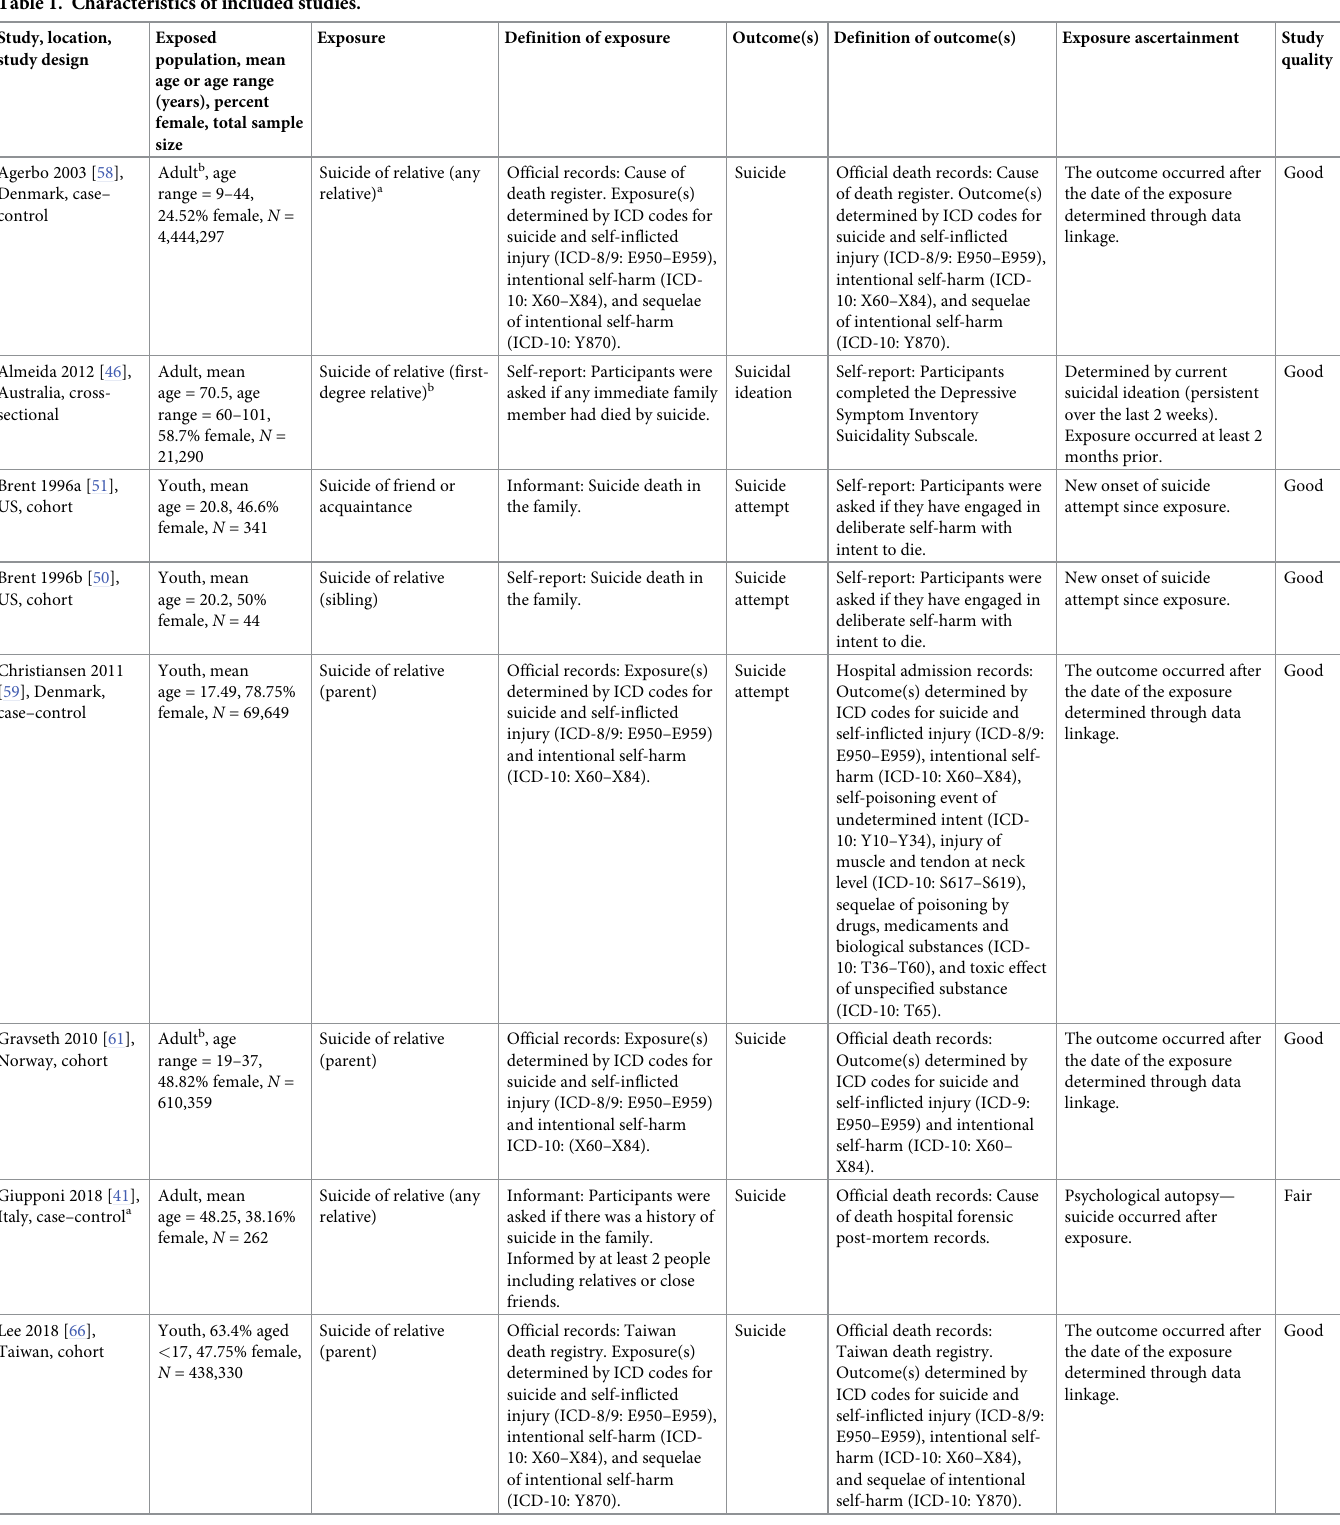
Table 1. Characteristics of included studies. Study, location, study